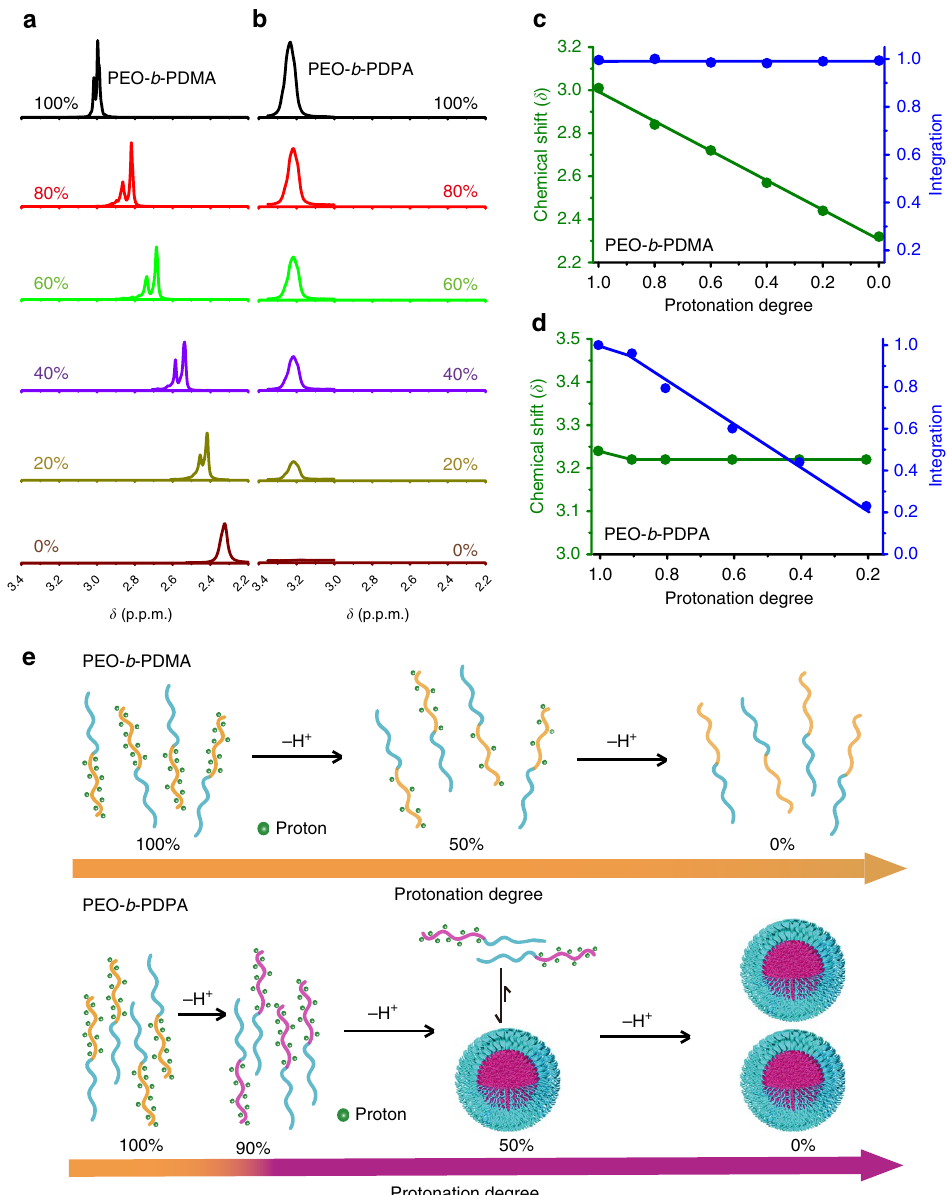
Figure 4 | Molecular pathway of pH-triggered self-assembly of PEO- b -PDPA copolymers. ( a , b ) 1 H NMR spectra (in D 2 O) of methylene protons of PEO- b -PDPA and methyl protons of PEO- b -PDMA adjacent to nitrogen atoms at different protonation degrees, respectively. PEO- b -PDMA was used as negative control without nanophase separation. ( c , d ) Quantification of chemical shift and peak integration of chosen methyl and methylene protons in PEO- b -PDMA and PEO- b -PDPA, respectively. Integrations were calculated using polyethylene oxide (PEO) segments as internal reference. ( e ) Schematic illustration of two distinctive deprotonation pathways. Deprotonation of PEO- b -PDMA ammonium groups was gradual along the entire pH titration course. Deprotonation of PEO- b -PDPA ammonium groups displayed a binary copolymer populations consisting of highly charged unimers in solution and neutral copolymers inside